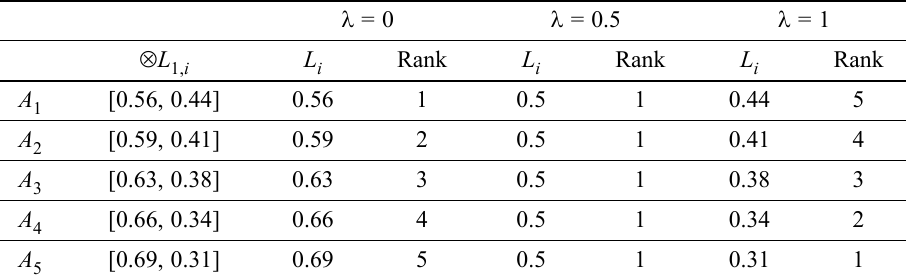
Table 15. The ranking results in the case of crisp ideal point λ =